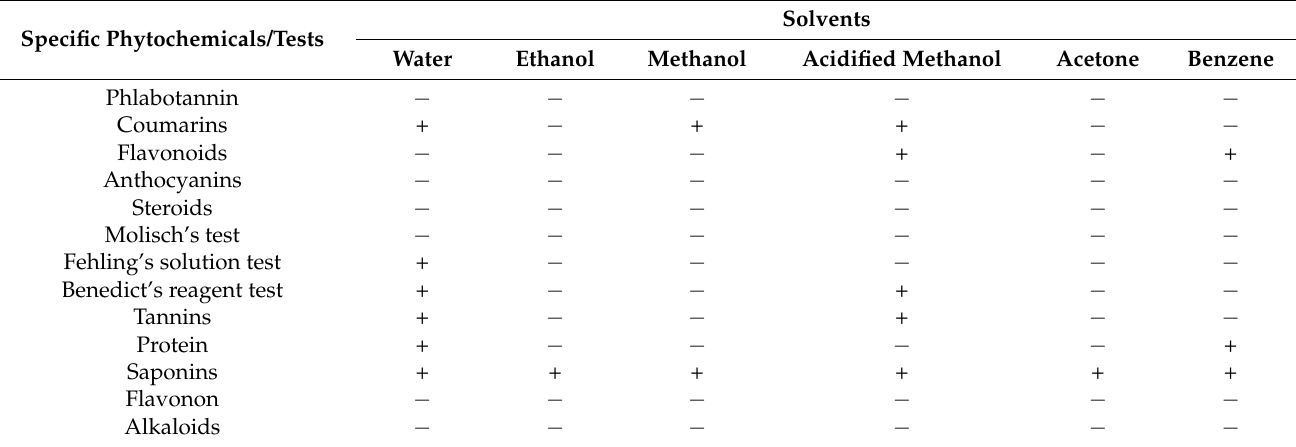
Table 1. Phytochemicals, sugar, protein and alkaloids in different rye extracts. Specific